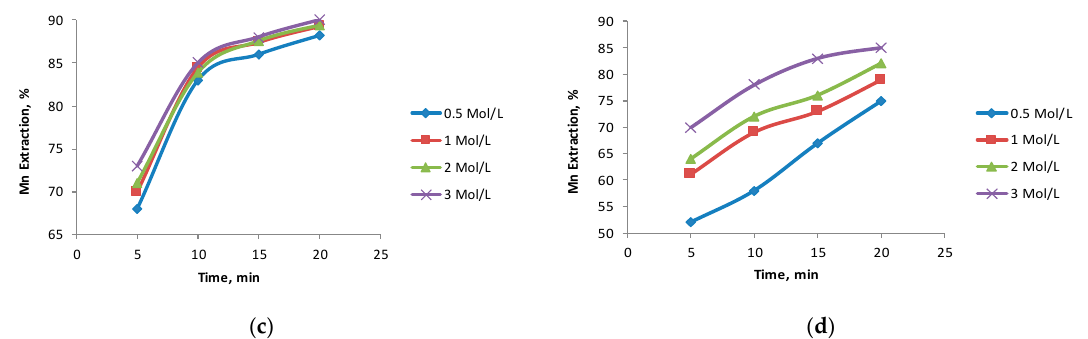
Figure 4. The effect of the sulfuric acid concentration on the system ( a ) BSCe-1; ( b ) BSC-2, MnO 2 /Fe 2 O 3 ratio of 1/2; ( c ) BSC-1; ( d ) BSC-2, MnO 2 /Fe 2+ ratio of 1/2.